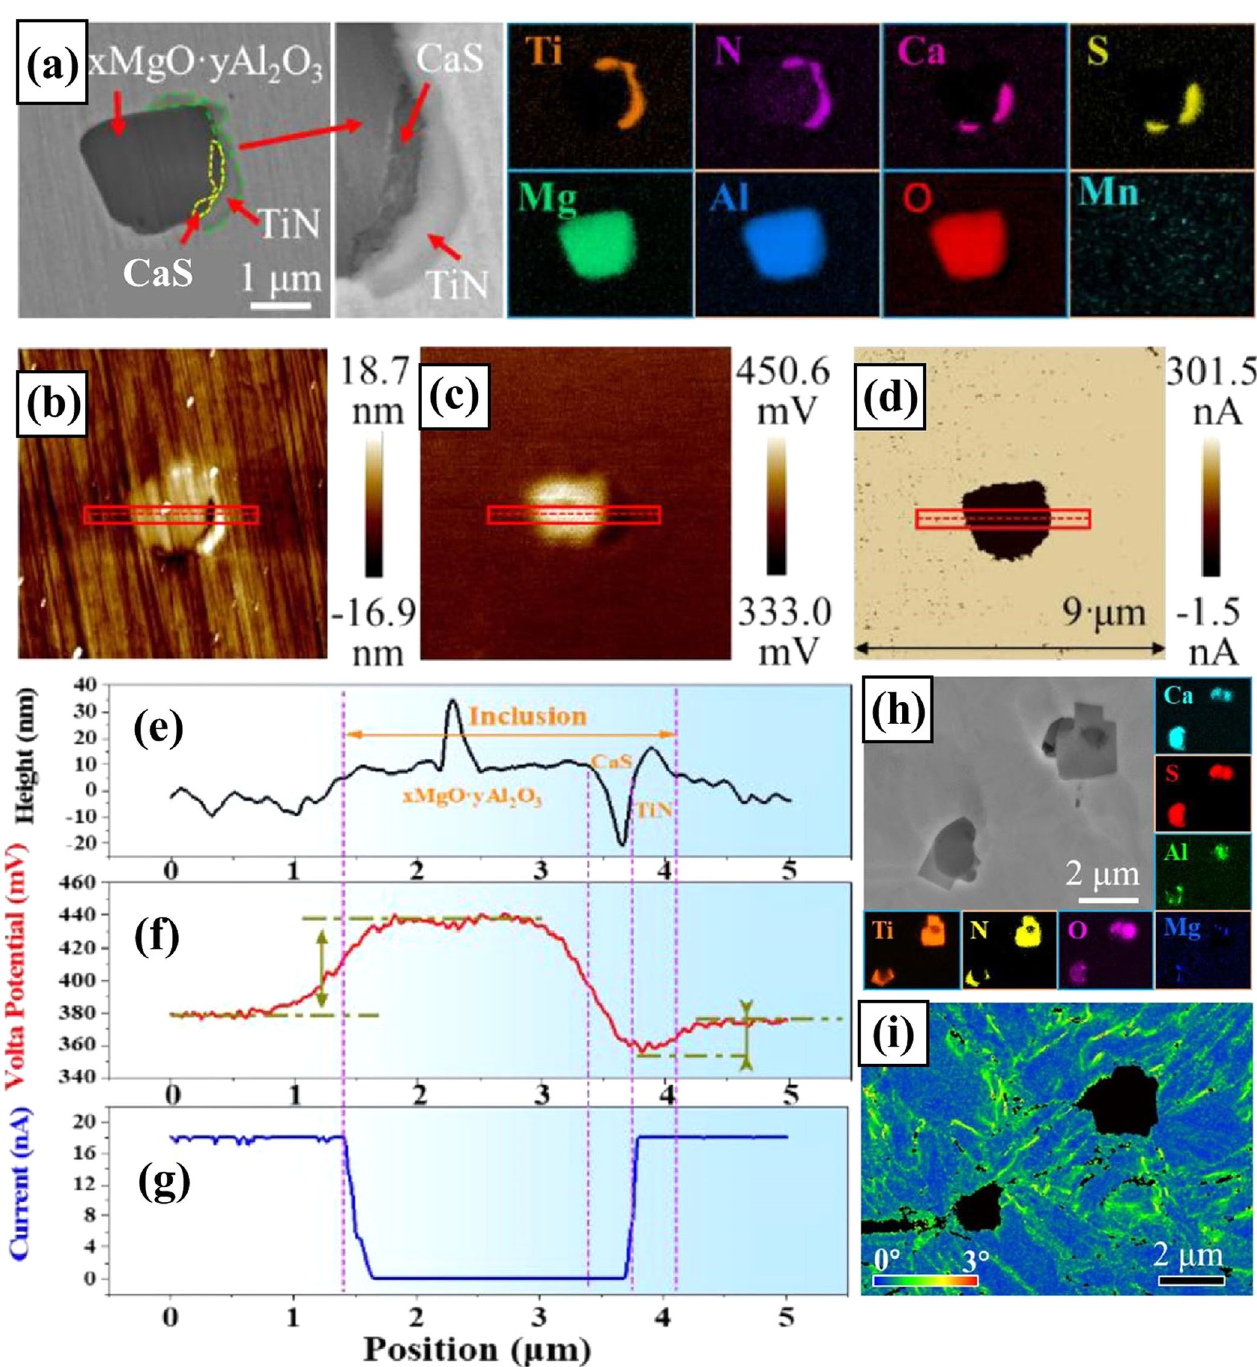
Fig. 12 Multiple characterization results of CaS· x MgO·yAl 2 O 3 ·TiN inclusions. a , h Morphology of typical target CaS· x MgO· y Al 2 O 3 ·TiN inclusions and the corresponding element distribution. b Topography map, c potential map and d conductive map of the same region shown in a . e – g The strip pro fi le analysis results of the target inclusions shown in a . i The KAM map of the same region shown in h 22